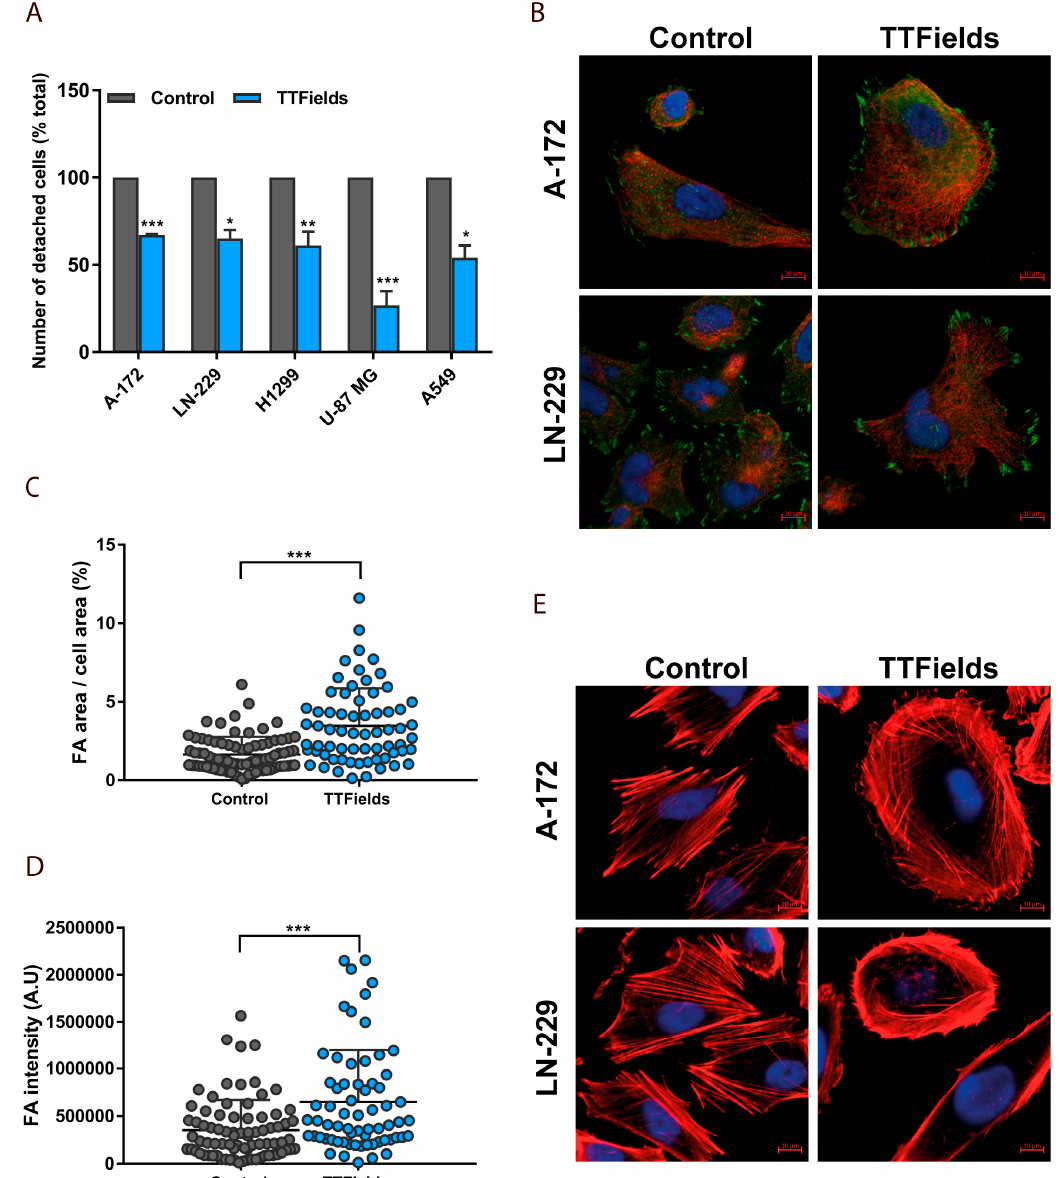
Figure 4. TTFields induce formation of focal adhesions (FA) and reorganization of the actin cytoskeleton in glioblastoma and lung adenocarcinoma cells ( A ) U-87 MG, A-172, and LN-229 glioblastoma cell lines and A549 and H1299 lung adenocarcinoma cell lines were treated continuously with TTFields for 24 h. Kinetics of cell surface detachment demonstrated a di ff erence in surface binding without TTFields (control) and with TTFields treatment. The bars indicate selected time point for each cell line. Mean + SEM; paired t -test. ( B ) A-172 and LN-229 cells were treated with TTFields for 24 h. Confocal fluorescence microscopy images of vinculin, a common marker of focal adhesions in control cells (left panels) and TTFields-treated cells (right panels) are shown. Blue, DAPI-stained DNA; Red, Tubulin; Green, vinculin. Scale bars: 10 µ m. Assessment of focal adhesion parameters ( C ) Quantification of focal adhesions area relative to cell area in LN-229 cells. Mean + SD; paired t -test. ( D ) Quantification of focal adhesions intensity. ( E ) A-172 and LN-229 cells were fixed and stained for F-actin following application of TTFields for 24 h. Left panel, control cells. Right panel, TTFields-treated cells. Blue, DAPI-stained DNA; Red, Phalloidin-stained Actin. Scale bars: 10 µ M. * p < 0.05, ** p < 0.01, and *** p <